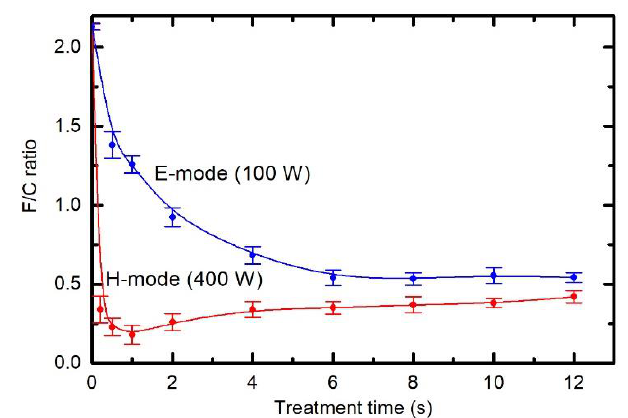
Figure 6. Variation of the X-ray photoelectron spectroscopy (XPS) F/C ratio versus treatment time for two different powers. Hydrogen pressure was constant at 25 Pa.